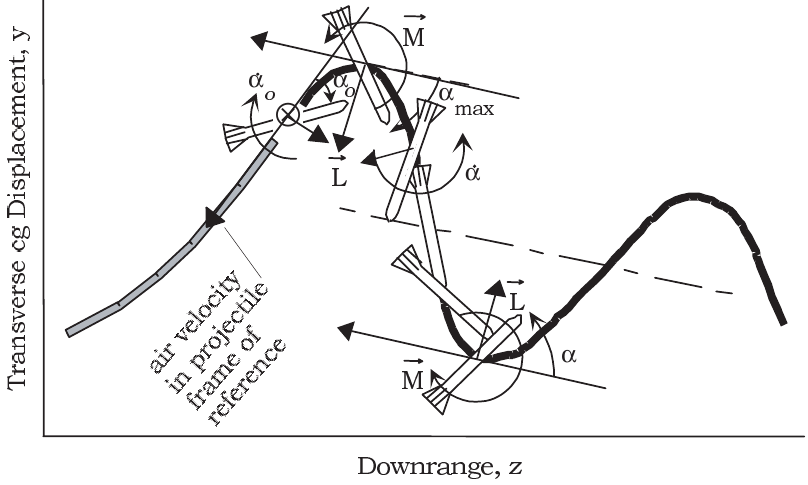
Fig. 10. Angular orientations of a KE rod consistent with the CG trajectory of Figs 2, 3, 5 and